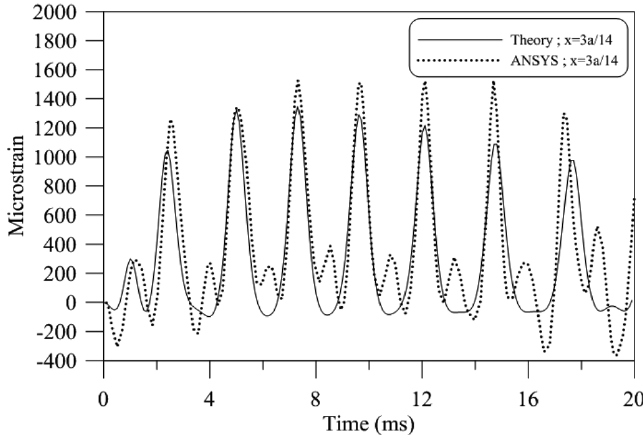
Fig. 11. The strain-time history ( ε xb − t ) at bottom surface of point (3a/14,